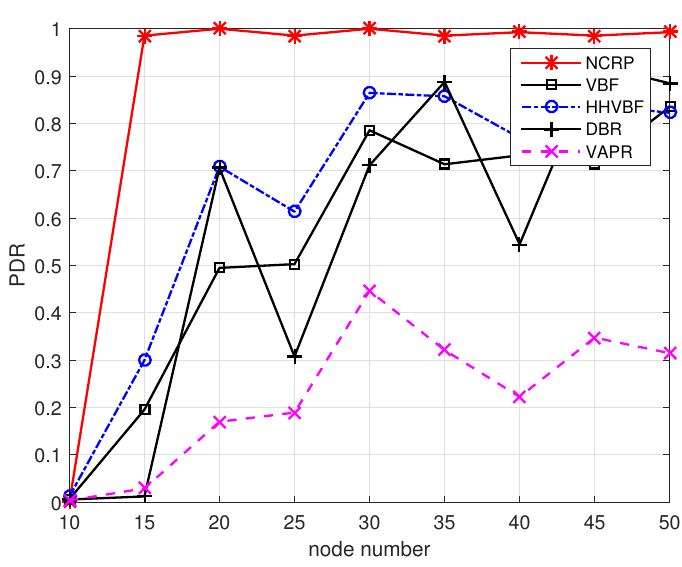
Figure 12. PDR performance with varying node numbers.